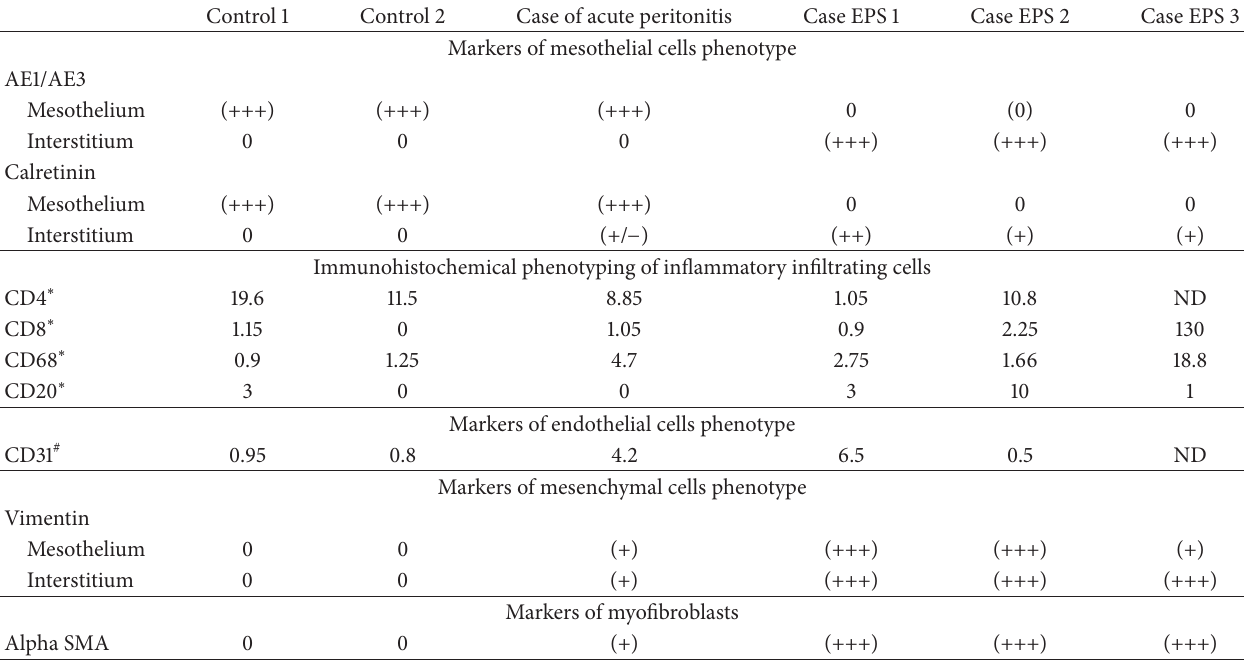
Table 3: Results of immunohistochemical quantifications of mesothelio-mesenchymal transdifferentiation process, evaluation of interstitial inflammation, and vasculature in peritoneal biopsies samples from controls, case of acute peritonitis, and patients with encapsulating peritoneal